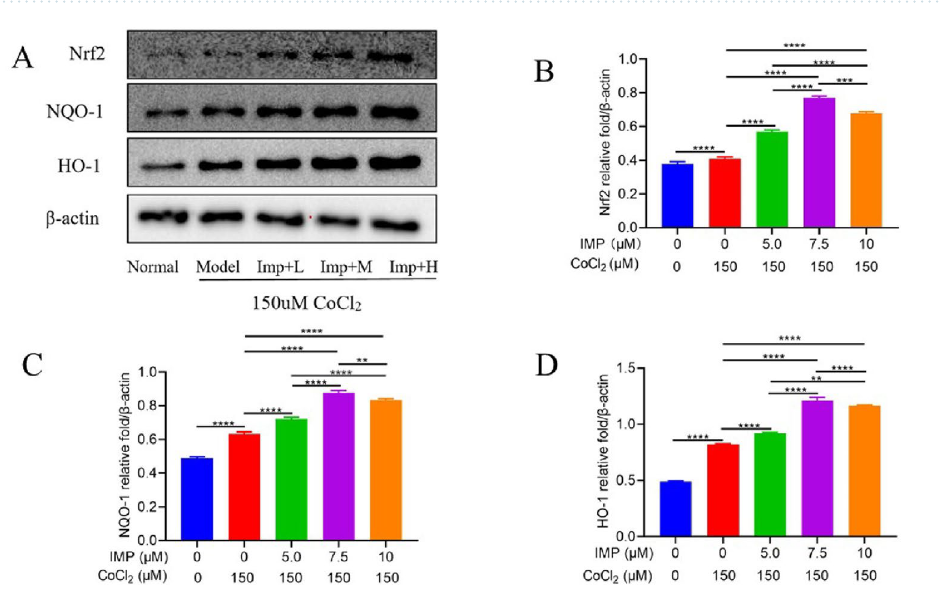
Figure 8. The effects of IMP on the expression of Nrf2, NQO-1 and HO-1 protein after 24 h intervention in hippocampal neuronal cells. ( A ): the western blot images of Nrf2, NQO-1, HO-1, and β-actin expression, ( B ): the relative expression of Nrf2, ( C ): the relative expression of NQO-1, ( D ): the relative expression of HO-1. Dividing lines were used to make explicit for the grouping of blots cropped from diferent parts of the same gel or from diferent gels. The experiment was repeated three times, and the data was shown as mean ± standard deviation. (n = 3 for every group, ** P < 0.01, *** P < 0.001, **** P <